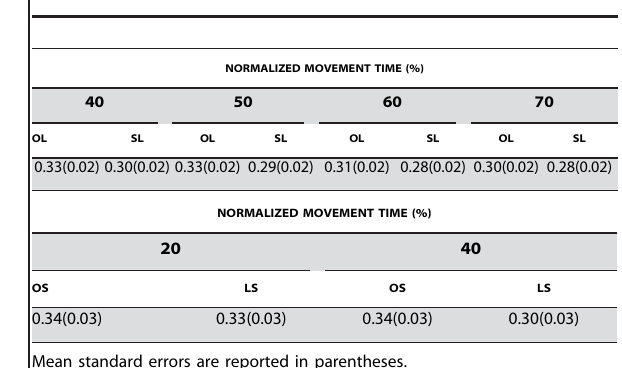
Table 4. Average absolute value of the slopes of the regression lines fitting angular values for each articulations’ pair at different epochs of normalized movement